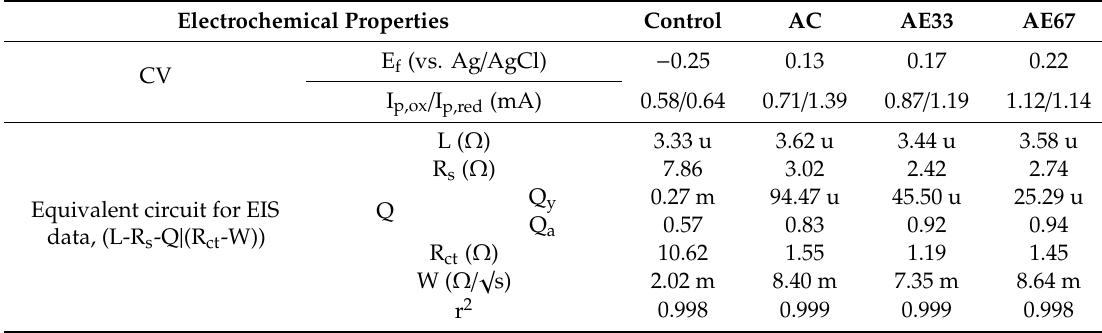
Table3. Electrochemicalpropertiesinelectrochemicalimpedancespectroscopy(EIS)ofthebulksolution. Electrochemical